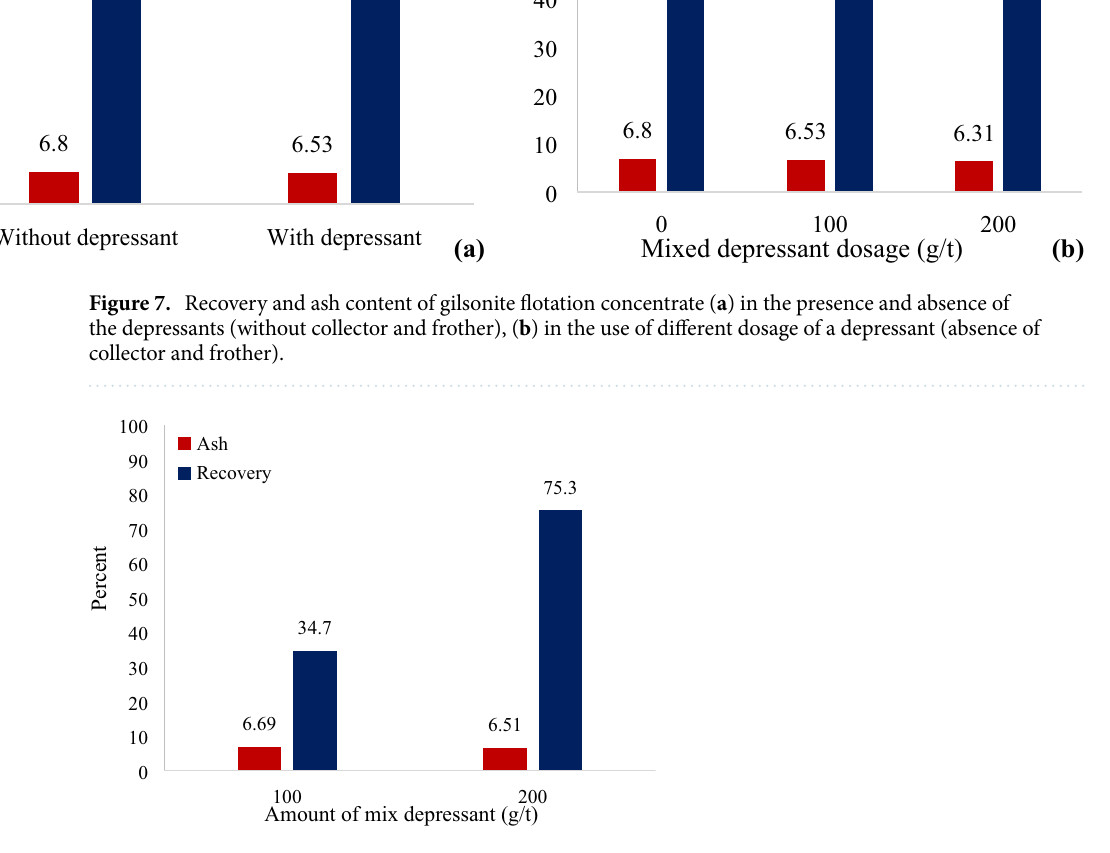
Figure 8. Effect of increasing depressant concentration on gilsonite flotation in the presence of kerosene and